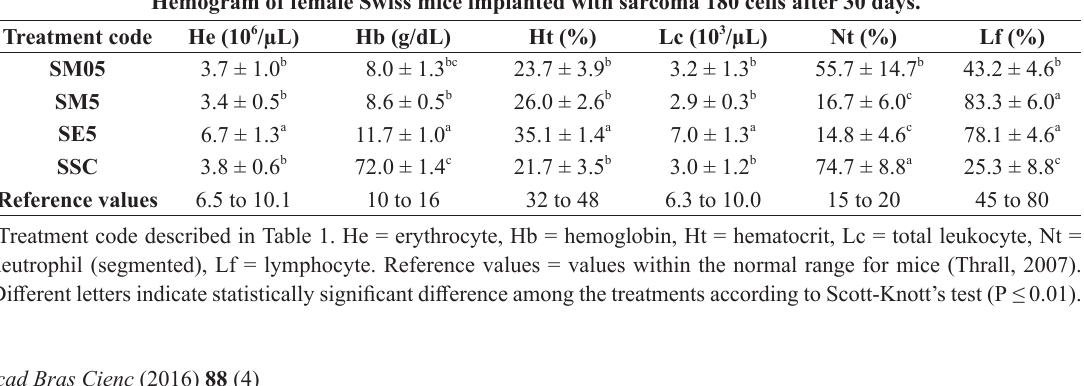
Hemogram of female swiss mice implanted with sarcoma 180 cells after 30 days. treatment code